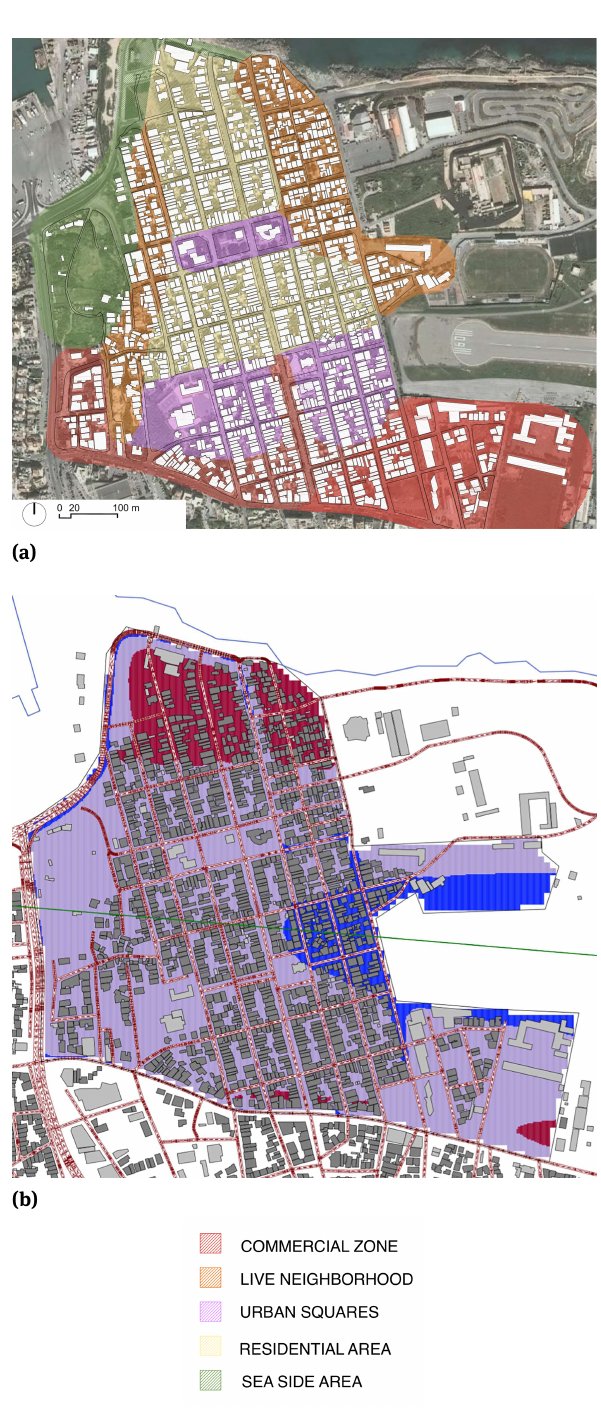
Figure 10: Sound identity map (a) without air traflc and (b) SNM with air traflc (take offs) for Alikarnassos District – Heraklion U.A., 2013.